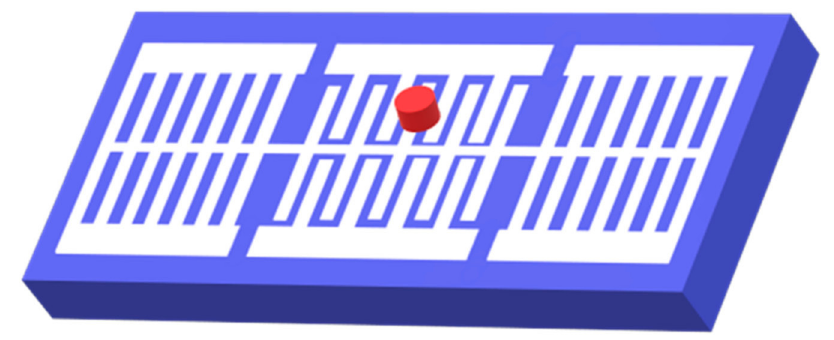
Figure 7. TC-SAWR device with a SiO 2 cylinder attached to its surface.